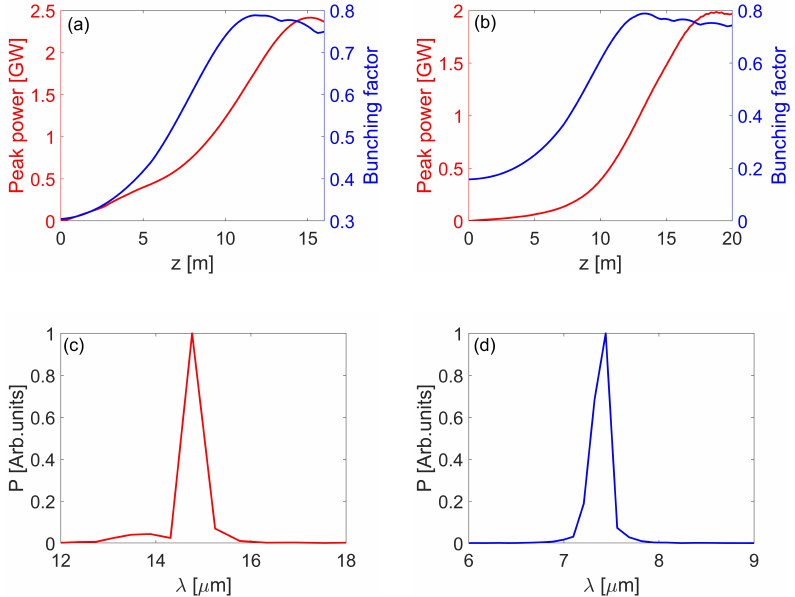
Figure 7. The evolutions of peak power and bunching factor at 15 µ m ( a ) and 7.5 µ m ( b ). The THz radiation spectra at 15 µ m ( c ) and 7.5 µ m ( d